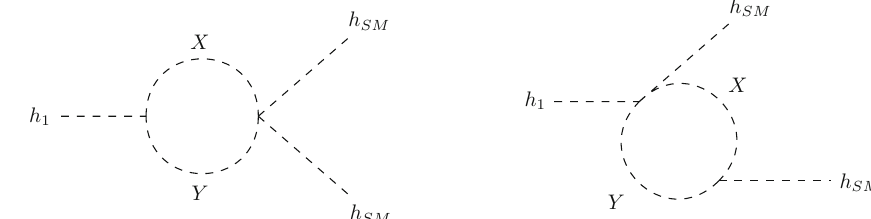
Fig. 2 Scalar loop